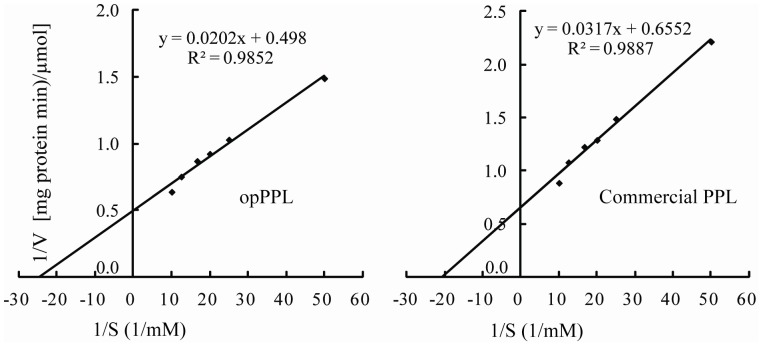
The Km value of opPPL and commercial PPL against p-NPP determined by Lineweaver-Burk method.(A) The Km value of opPPL. (B) The Km value of commercial PPL.